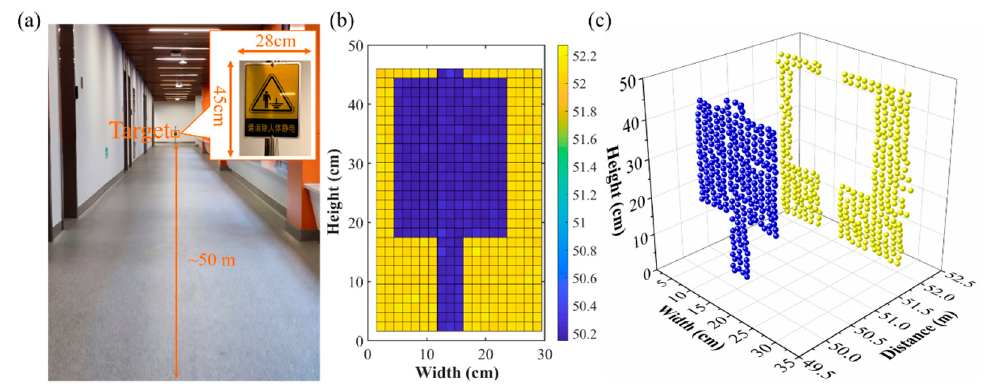
Figure 8. ( a ) The photograph of scanning target, ( b ) the front view of imaging picture, ( c ) the point cloud of imaging picture.